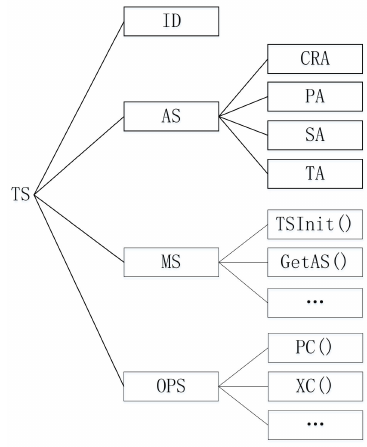
Figure 3. The traceability